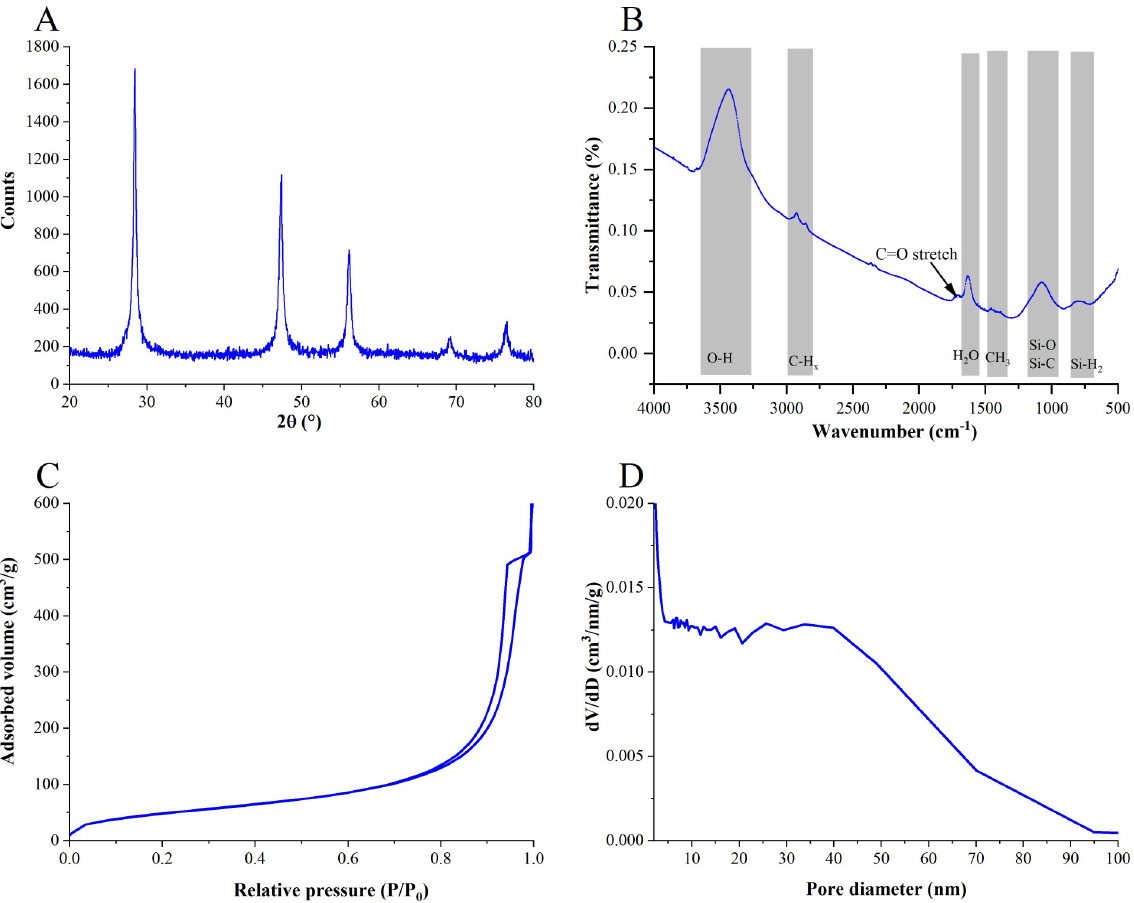
Fig 2. Characterization of the nanoparticles. (A) XRD diffractogram. (B) FTIR spectra. (C) N 2 adsorption/desorption isotherms. (D) pore size distribution determined from the adsorption branch of the isotherm using the BJH theory.